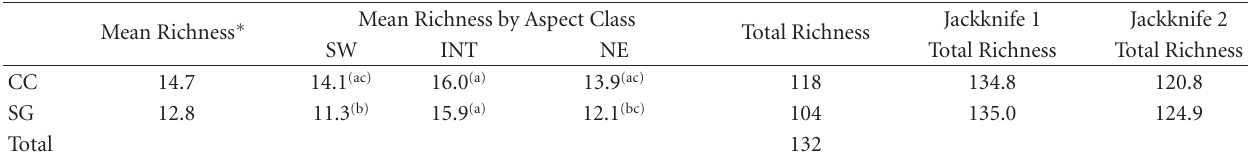
Table 1: Mean, total, and Jackknife estimated species richness of aboveground vegetation in 192 quadrats established in six revegetating clearcut (CC; ∼ 7 years) and six second-growth (SG; ∼ 125 years) forest stands at WWRS. Asterisk ( ∗ ) indicates significant di ff erence in CC and SG richness ( P < . 05). Letters indicate significant di ff erence among CC/SG topographic aspect classes ( P < .